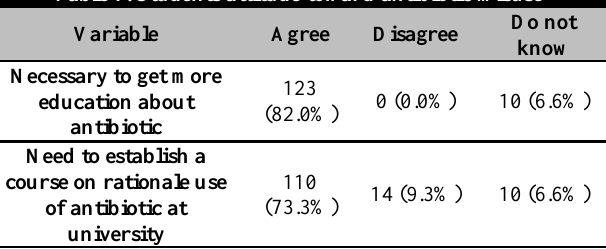
Table 7. Students attitude toward antibiotic